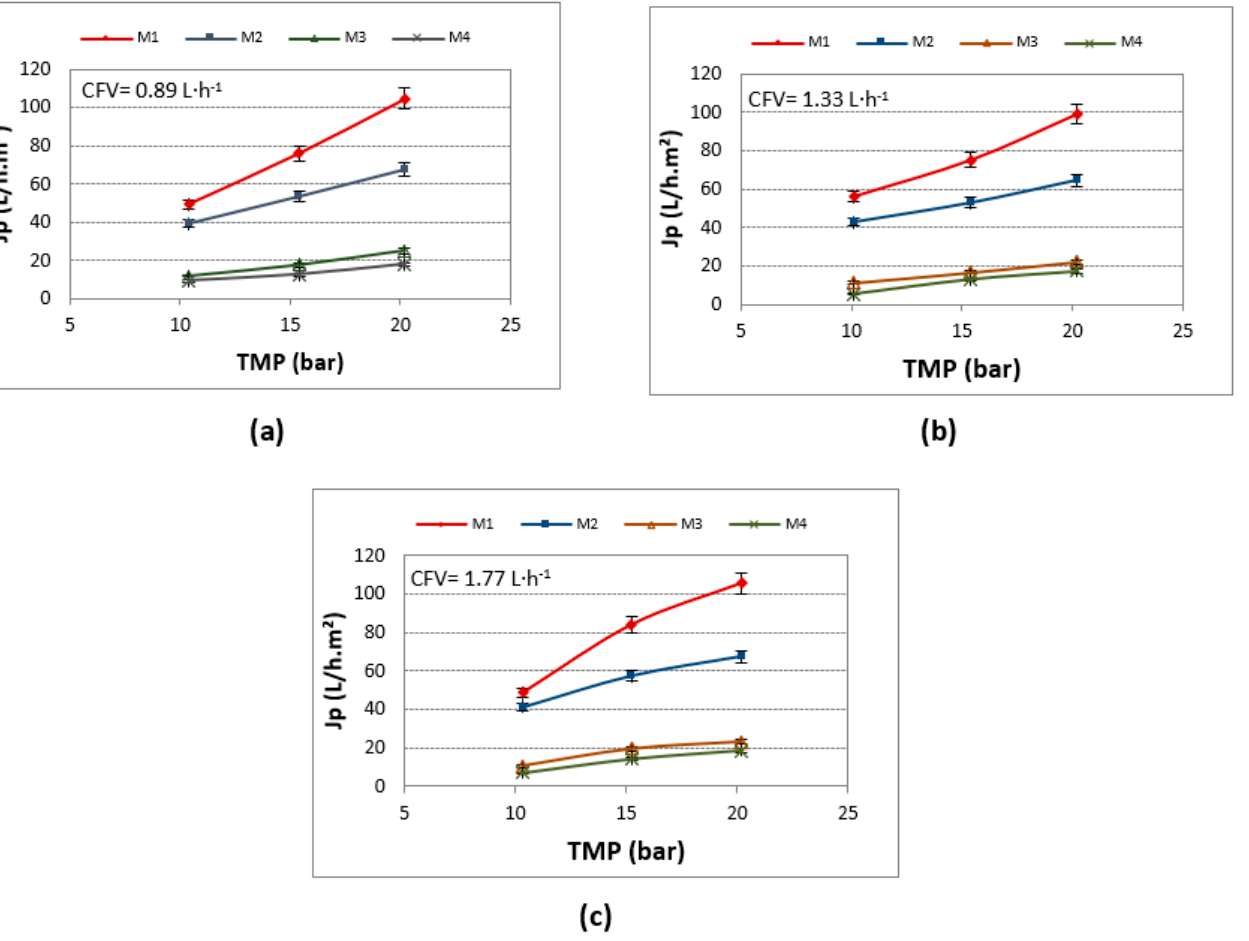
Figure 2. Influence of TMP on the permeate flux at different CFVs for: ( a ) 0.89 L·h − 1 ; ( b ) 1.33 L·h − 1 ; · h − 1 ( c ) 1.77 L·h − 1 . ( c ) 1.77 L